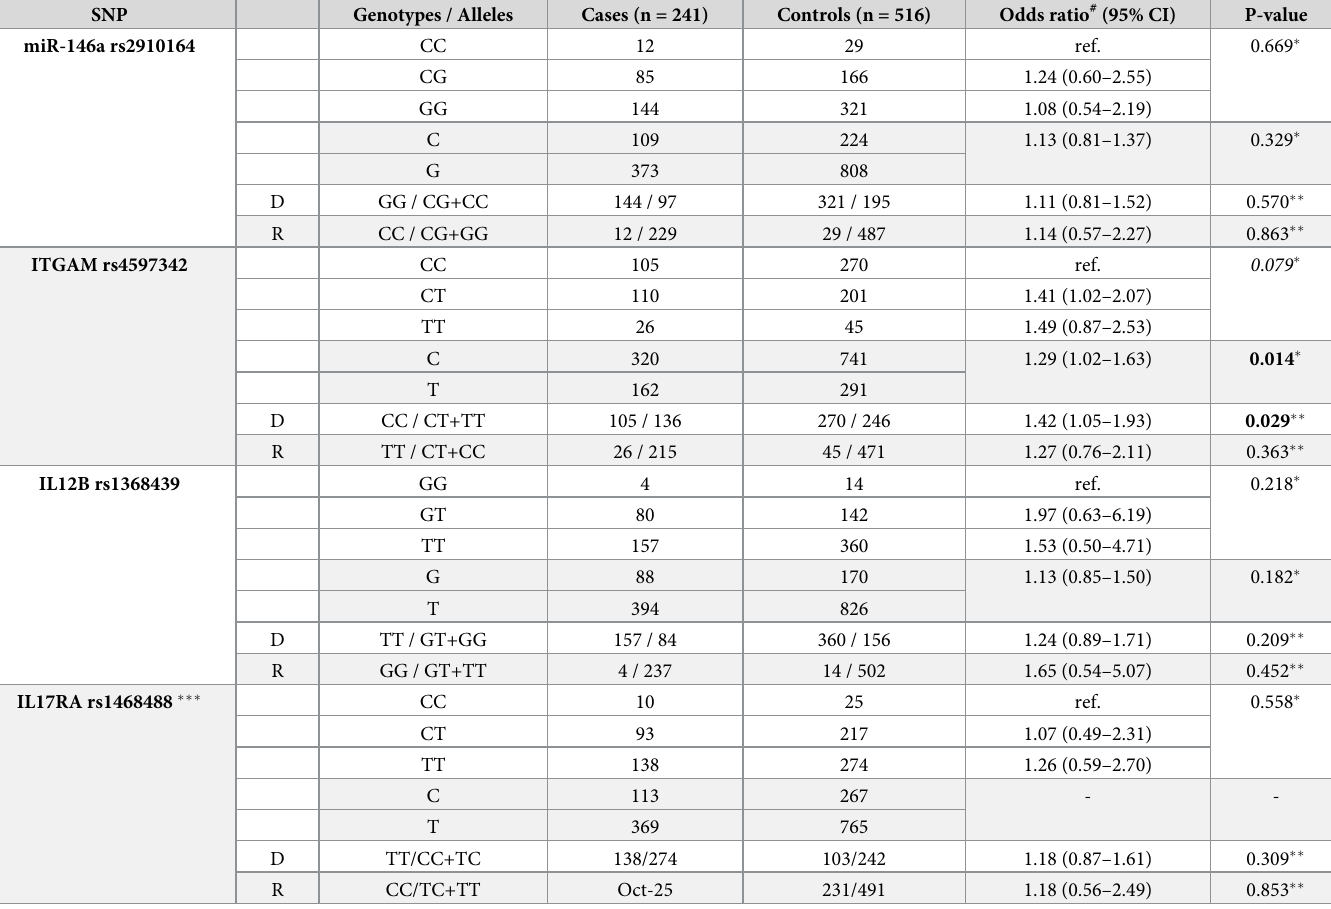
Table 1. Genotype and allele analysis of studied SNPs.